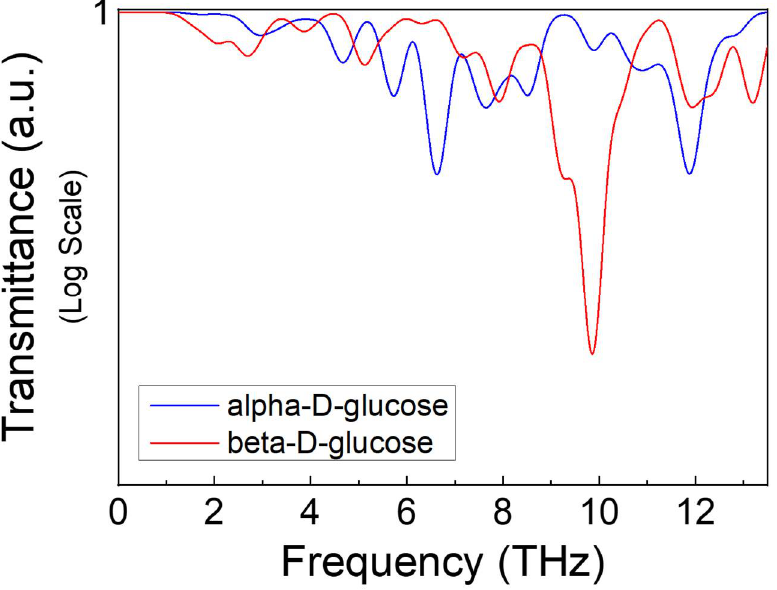
Figure 2. Theoretical transmittance spectra of α - and β -D-glucose crystals. The line spectra were Gaussian broadened with a FWHM of 0.5 THz.